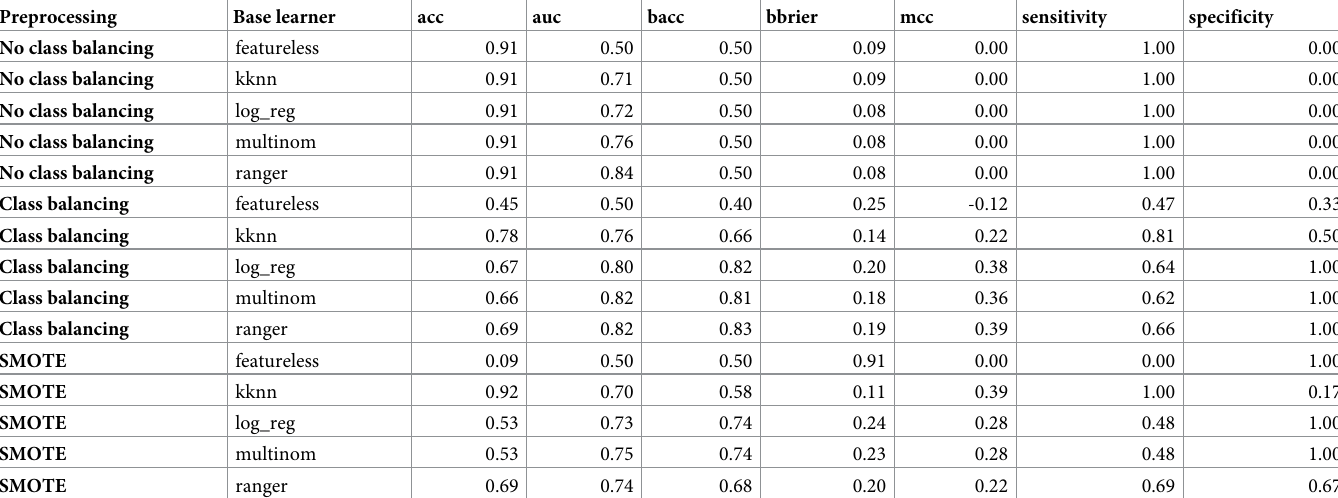
Table 5. Comparison of different class balancing approaches on binary classifier model performance on validation data. Preprocessing